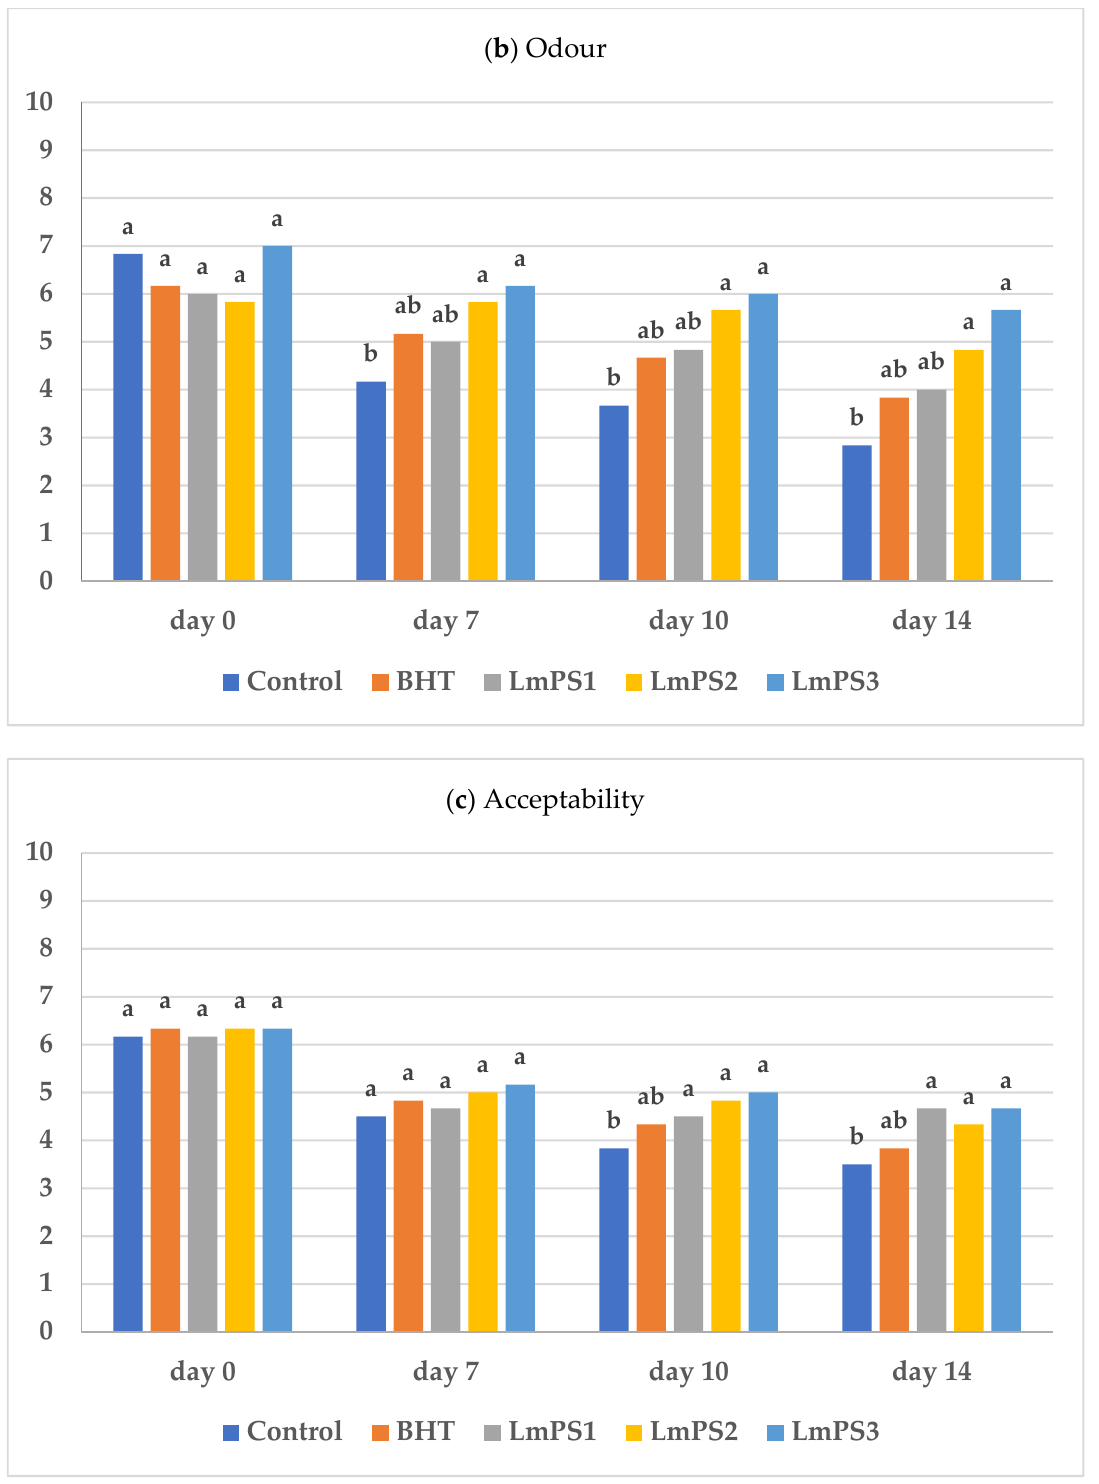
Figure 2. Organoleptic quality (( a ) colour, ( b ) odour and ( c ) overall acceptability) of raw minced meat beef stored at T = 4 °C, using different preserving agents. In each group (same day of storage) different letters indicate mean values significantly different ( p < 0.05).